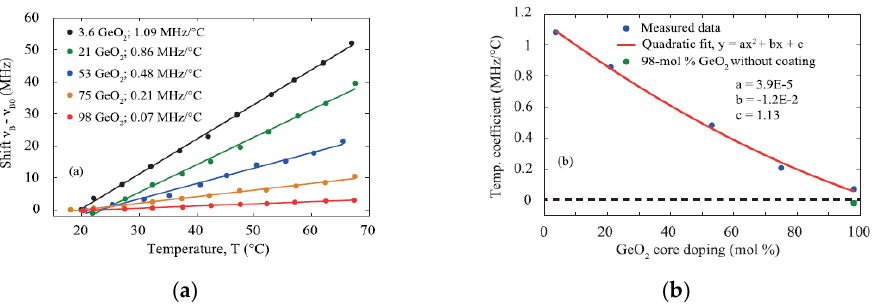
Figure 5. Experimental setup of distributed temperature and strain sensing using BDG and BGS. Reproduced from [31]. Copyright (2017) The Japan Society of Applied Physics.